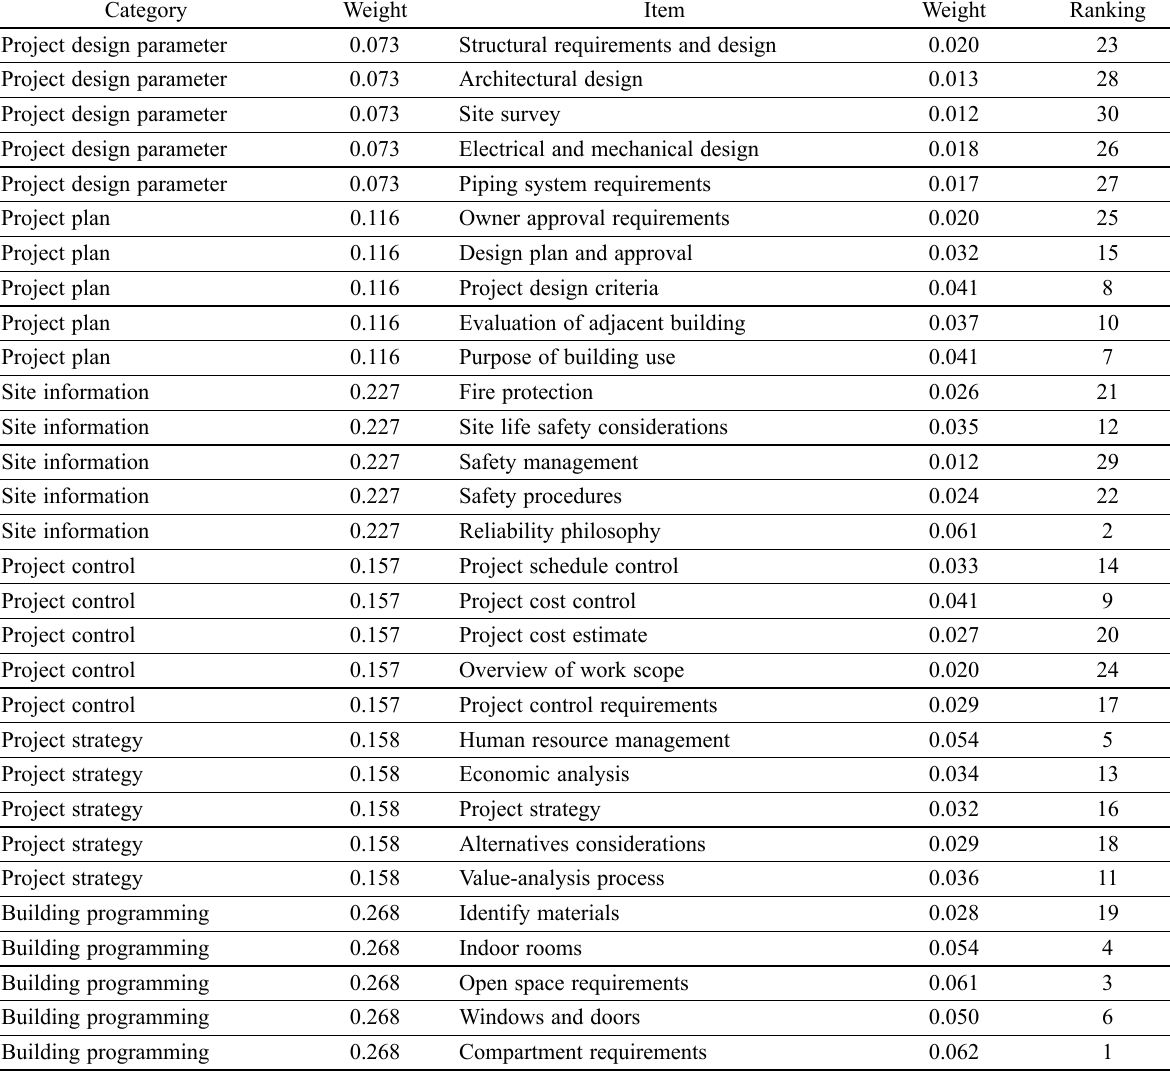
Table 3. Criteria in the ANP model Category